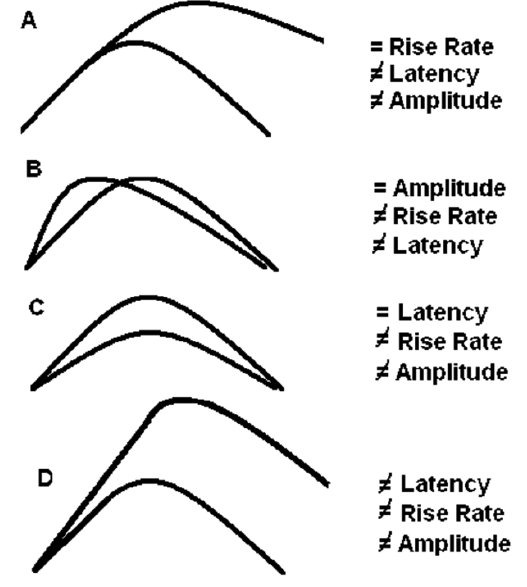
Figure 6 - Drawings of pairs of waves showing similarities (=) and differences (≠) with respect to their parameter relationships. The waves can be equal in their rate of rise ( A ), their amplitude ( B ), or their latency ( C ) but are different in the other measures. The two waves can also be different in all their parameters ( D